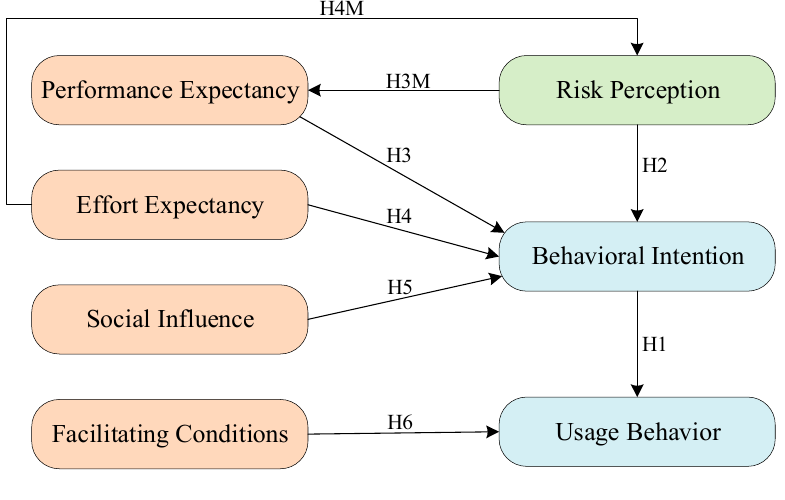
Figure 1. Conceptual framework.